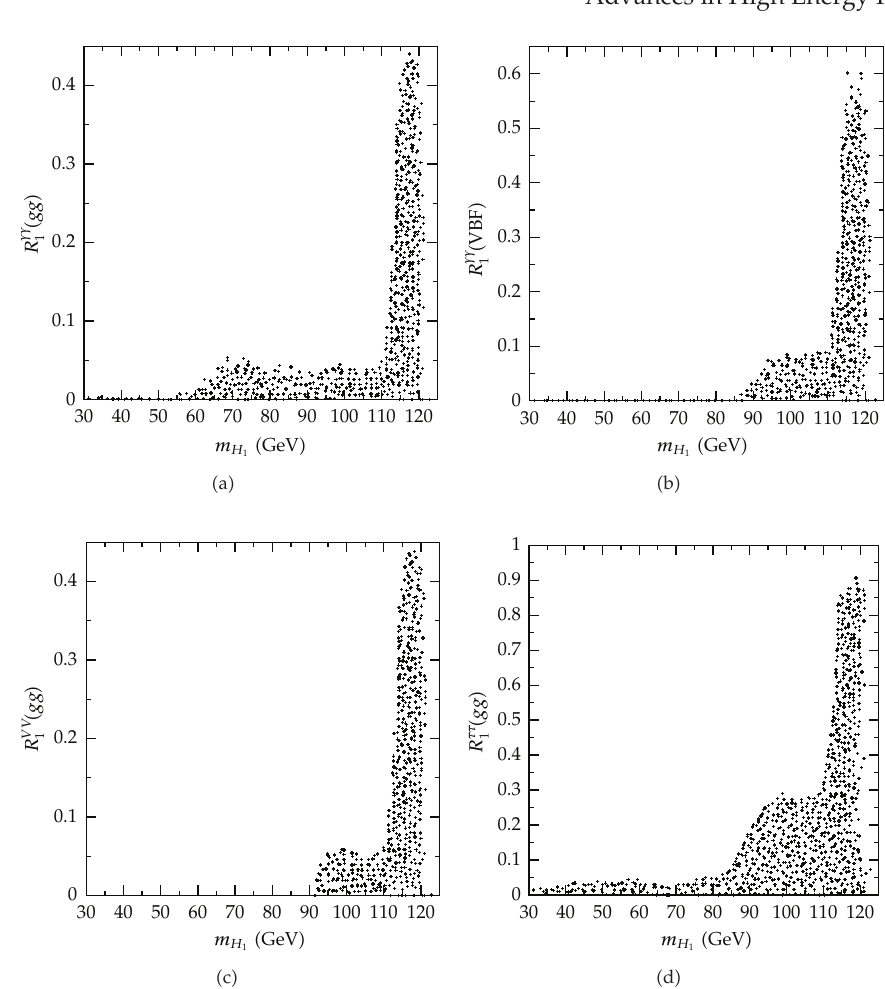
(cid:2) gg (cid:3) (cid:2) diphoton channel, H . (cid:2) a (cid:3) R γγ 1 1 1 (cid:3) , (cid:2) c (cid:3) R VV (cid:2) gg (cid:3) 1 production via VBF 1 (cid:3) , and (cid:2) d (cid:3) R ττ (cid:2) VBF (cid:3) (cid:2) ττ channel, H 1 production 1